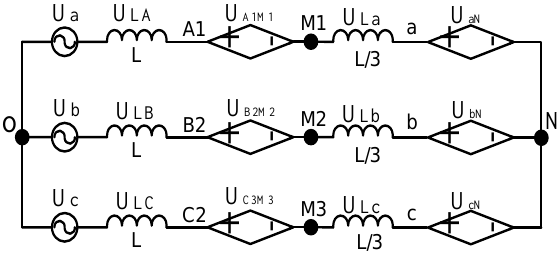
Figure 5. The equivalent star-connected circuit of three-phase delta connected LVC-VC.